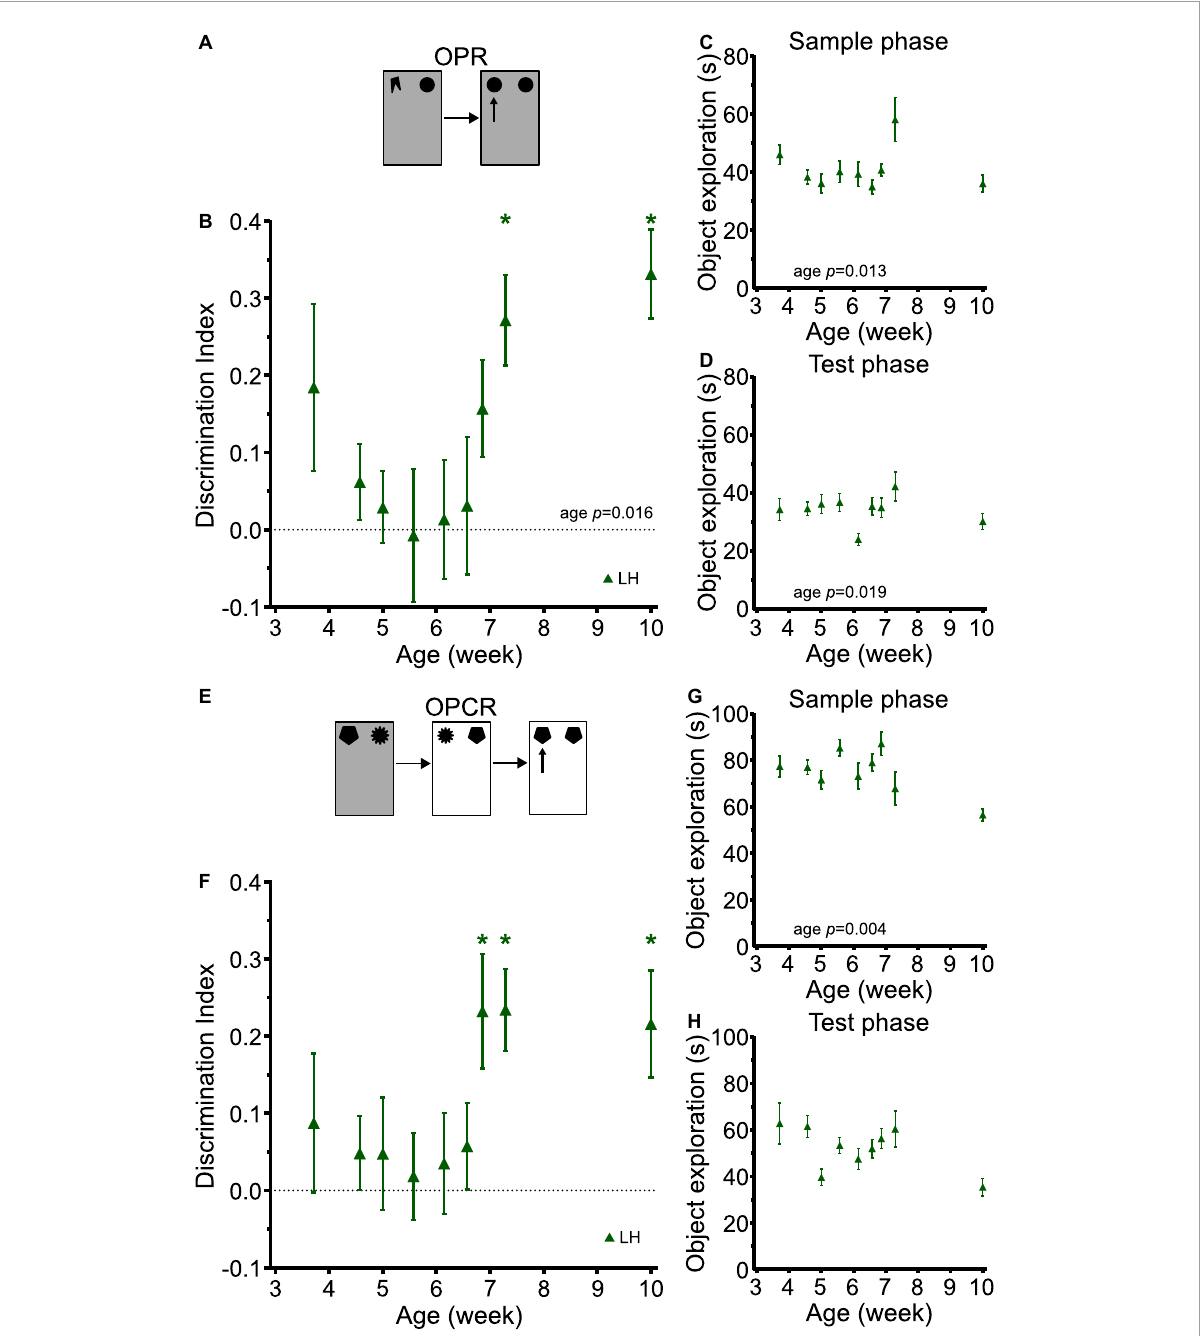
FIGURE7 LH rats exhibit similar developmental trajectories for object-place and object-place-context memory to LEH and SD rats. (A) Schematic of object-place recognition task; (B) Object-place recognition memory performance, expressed as discrimination index for different cohorts of rats tested at different ages. LH rats show significant object place recognition memory only on P51 and P71. * p < 0.05. A significant main effect of age was found; (C) Object exploration during OPR sample phase. A significant main effect of age was detected; (D) Object exploration during test phase. A significant main effect of age was detected; (E) Schematic of object-place-context recognition task. (F) Discrimination indices for Object-place-context recognition memory performance. LH rats show significant object place context recognition memory only on P48, P51, and P71. No significant effect of age was detected; (G) Object exploration during OPCR sample phases (mean of the two sample phases). A significant main effect of age was detected; (H) Object exploration during OPCR test phase. A significant main effect of age was detected. [OPR]: P26 (n ( females ) = 8, n ( males ) = 9), P32 (n ( females ) = 13, n ( males ) = 14), P35 (n ( females ) = 6, n ( males ) = 9), P39 (n ( females ) = 6, n ( males ) = 10), P43 (n ( females ) = 8, n ( males ) = 8), P46 (n ( females ) = 8, n ( males ) = 9), P48 (n ( females ) = 7, n ( males ) = 9), P51 (n ( females ) = 7, n ( males ) = 8), P71 (n ( females ) = 8, n ( males ) = 8); [OPCR]: P26 (n ( females ) = 8, n ( males ) = 8), P32 (n ( females ) = 13, n ( males ) = 14), P35 (n ( females ) = 6, n ( males ) = 10), P39 (n ( females ) = 6, n ( males ) = 10), P43 (n ( females ) = 6, n ( males ) = 6), P46 (n ( females ) = 8, n ( males ) = 8), P48 (n ( females ) = 7, n ( males ) = 8), P51 (n ( females ) = 6, n ( males ) = 6), P71 (n ( females ) = 7, n ( males ) = 8). For details on sample sizes, t , and p -values for one-sample t -tests, see Supplementary Table 2